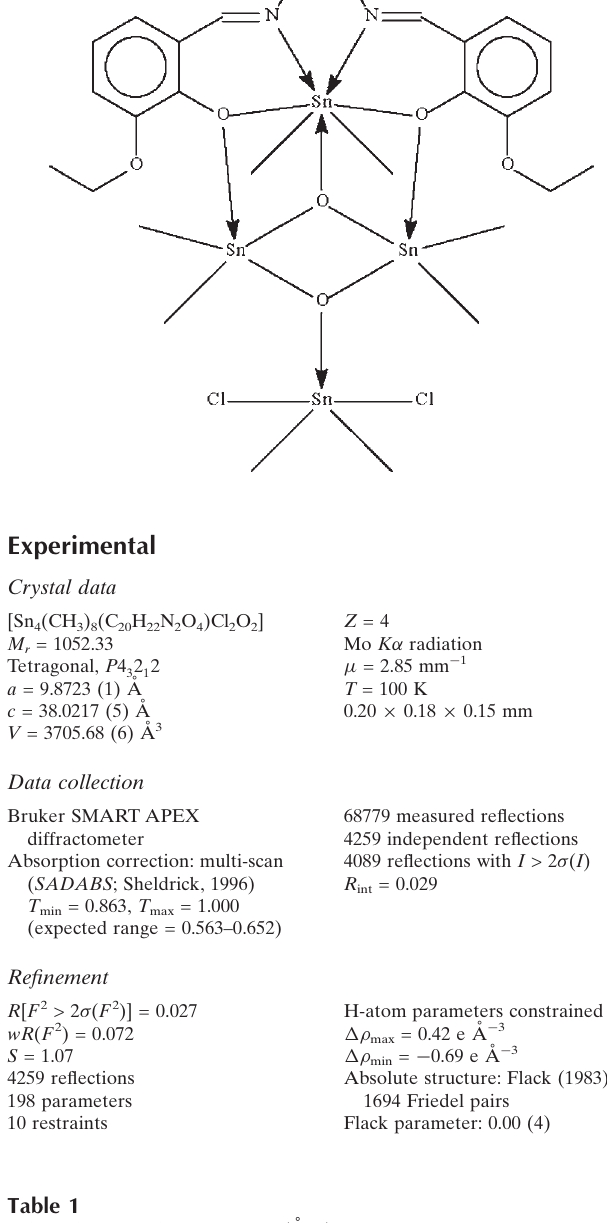
Selected geometric parameters (A˚ , (cid:4)